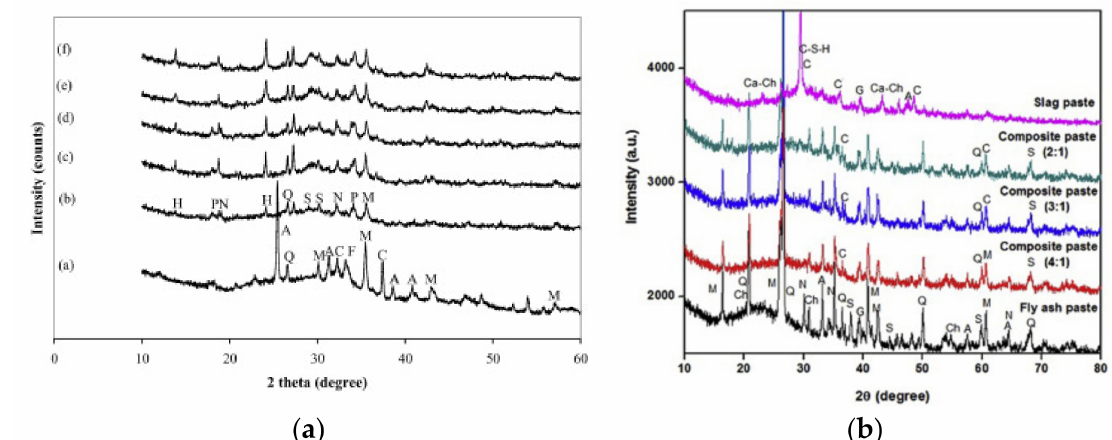
Figure 9. XRD characterization of FA-based geopolymer binders: ( a ) Effect of activator molarity. Reprinted with permission from Ref. [51]. Copyright 2014 Elsevier. and ( b ) Influence of GBFS content. Reprinted with permission from Ref. [52]. Copyright 2019